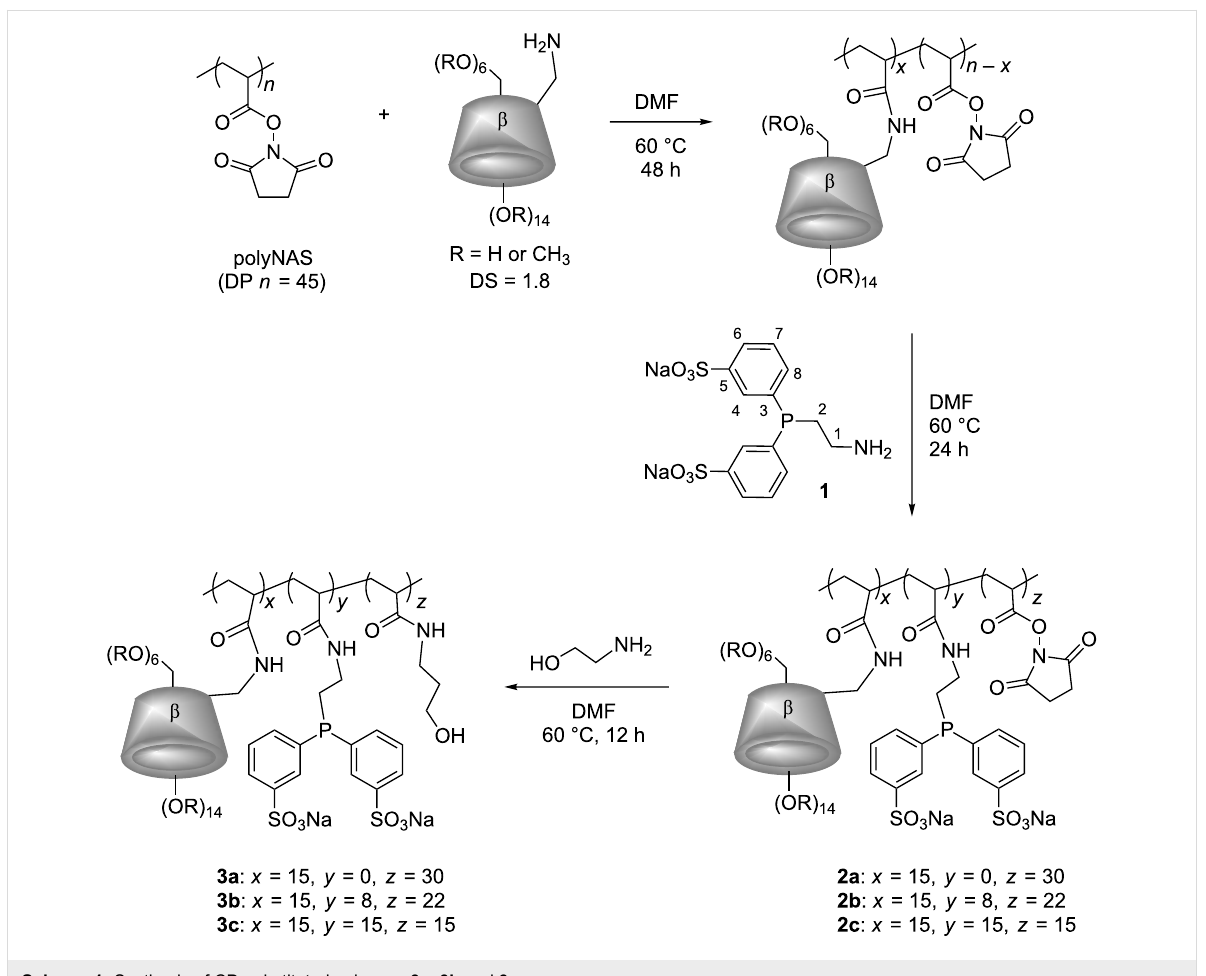
Scheme 1: Synthesis of CD-substituted polymers 3a , 3b and 3c